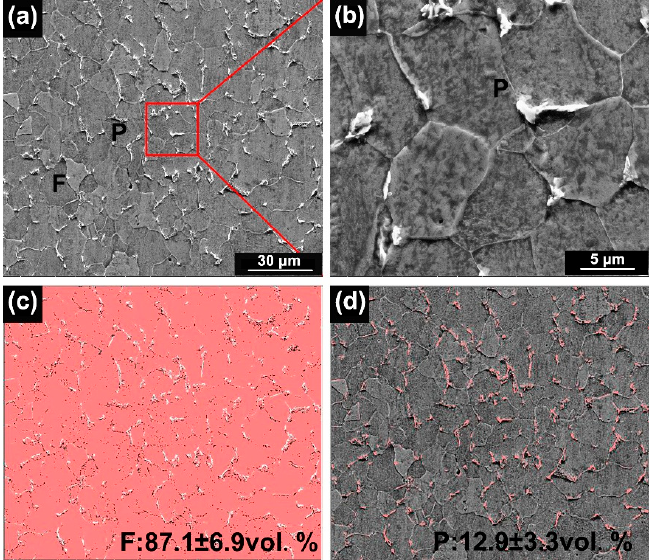
Figure 2. Original microstructure of low-carbon steel ( a , b ) F + P; ( c ) Measurement of F area; and, ( d ) Measurement of P area.